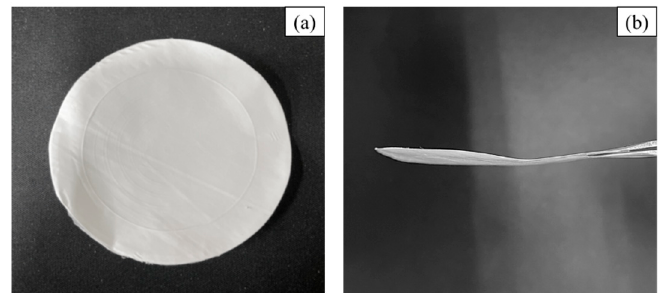
Figure 1. Appearance of the manufactured PP/AC/Gly separator. ( a ) Top view of the separator, ( b ) side view of the separator. ( b ) side view of the